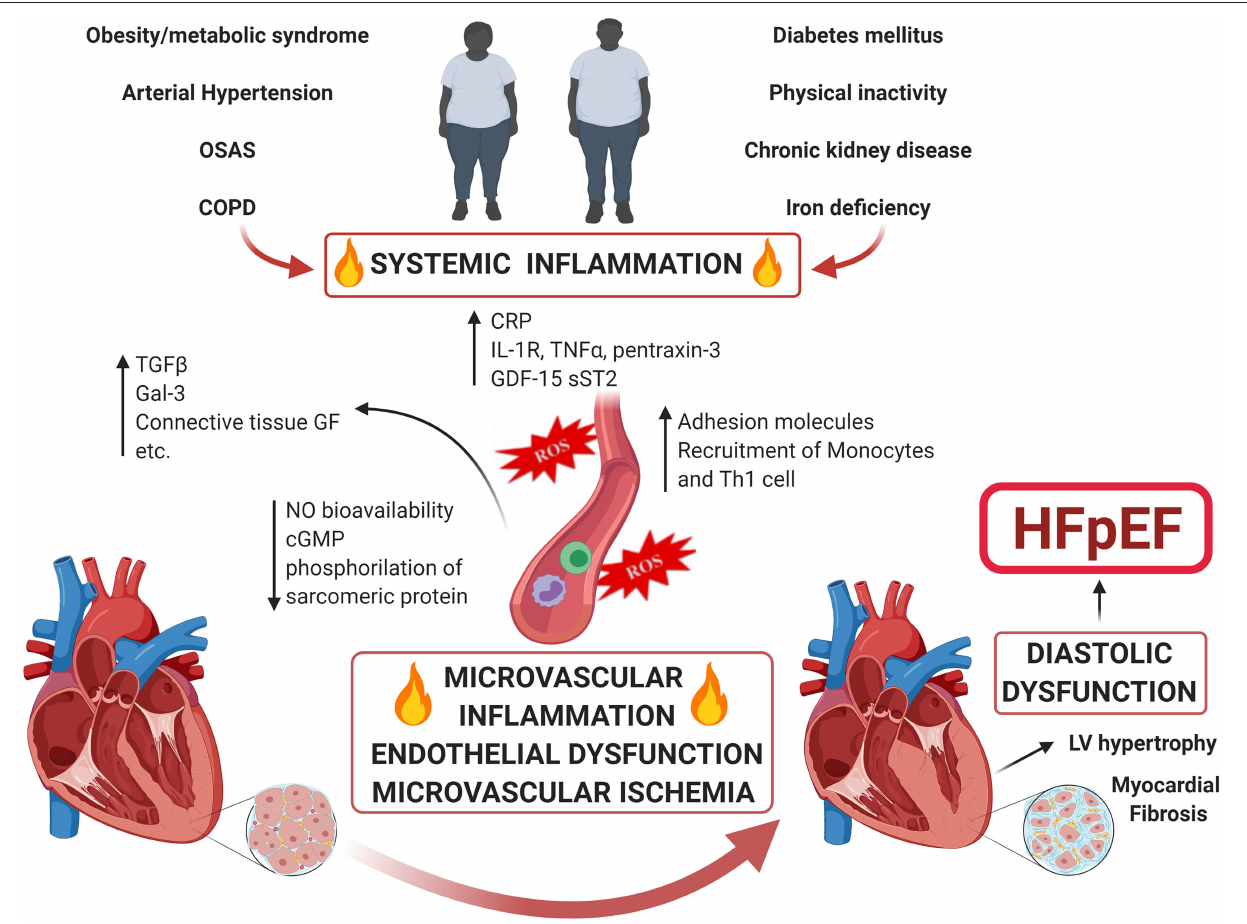
FIGURE 1 | Comorbidity-Driven Microvascular Inflammation Theory in HFpEF. Accumulated risk factors as well as cardiac and non-cardiac comorbidities lead to a systemic inflammatory state and coronary microvascular inflammation. The endothelial dysfunction and perturbation of the physiology of the perivascular environment engage molecular pathways that ultimately converge to microvascular dysfunction and myocardial fibrosis causing